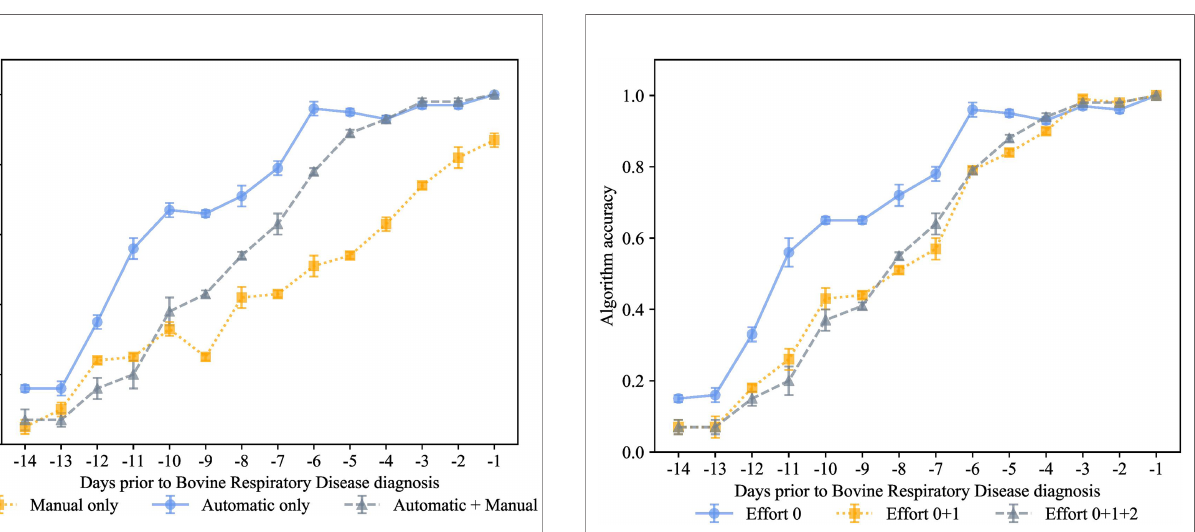
FIGURE 8 | How much information is needed to accurately indicate calves destined for bovine respiratory disease diagnosis? K-closest neighbor ’ s algorithm accuracy (mean ± SD) from 10 runs of cross-validation for predicting calves destined for bovine respiratory disease diagnosis using effort 0 features recorded by an automated milk feeder and accelerometer (blue line), effort 1 features of outward clinical signs of bovine respiratory disease + effort 0 (yellow line), or effort 2 features requiring calf restraint such as body weight, passive immunity status at 48 h of age, and rectal temperature + effort 0 + effort 1 (grey line) in a 106 dairy calf cohort followed for 50